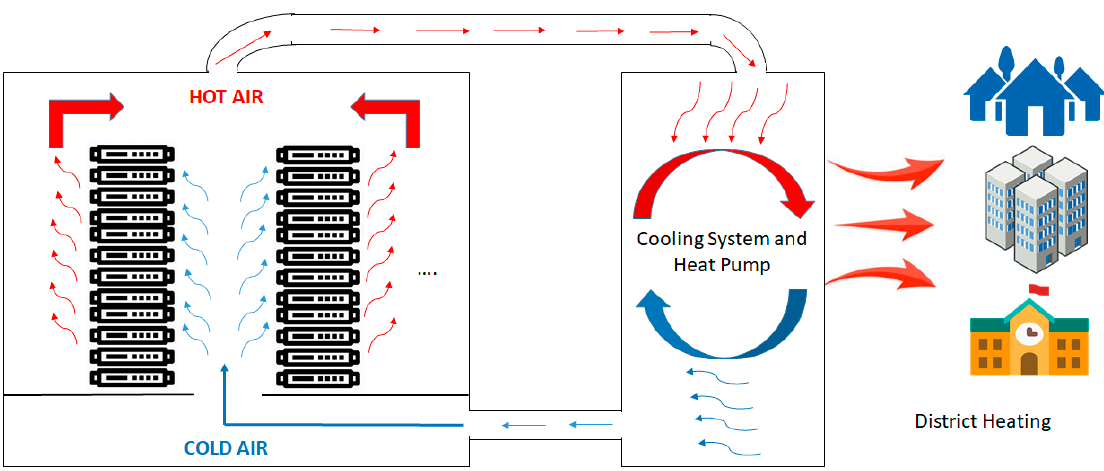
Figure 5. DC electrical air cooling infrastructure and heat reuse.